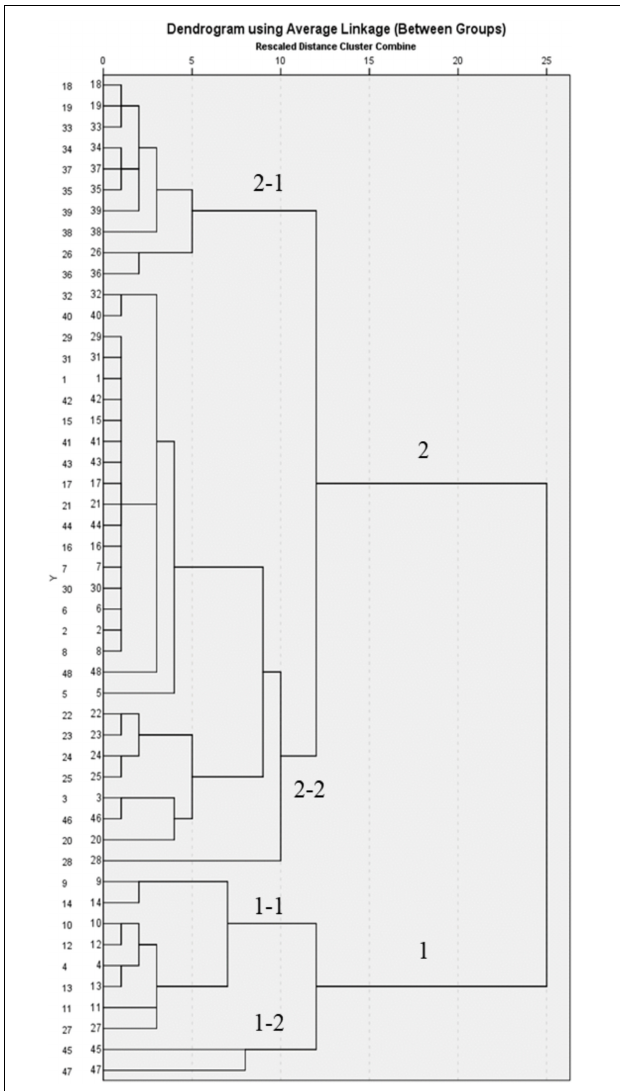
FIGURE 2 | Dendrograms of 48 batches of DOOS resulting from hierarchical clustering analysis.